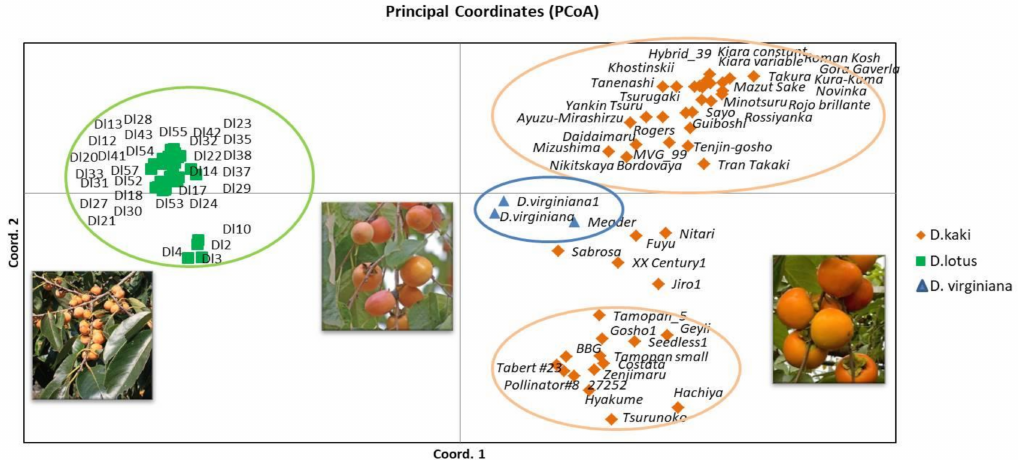
Figure 3. Principal coordinate analysis (PCoA) of pairwise distances between accessions calculated on ISSR